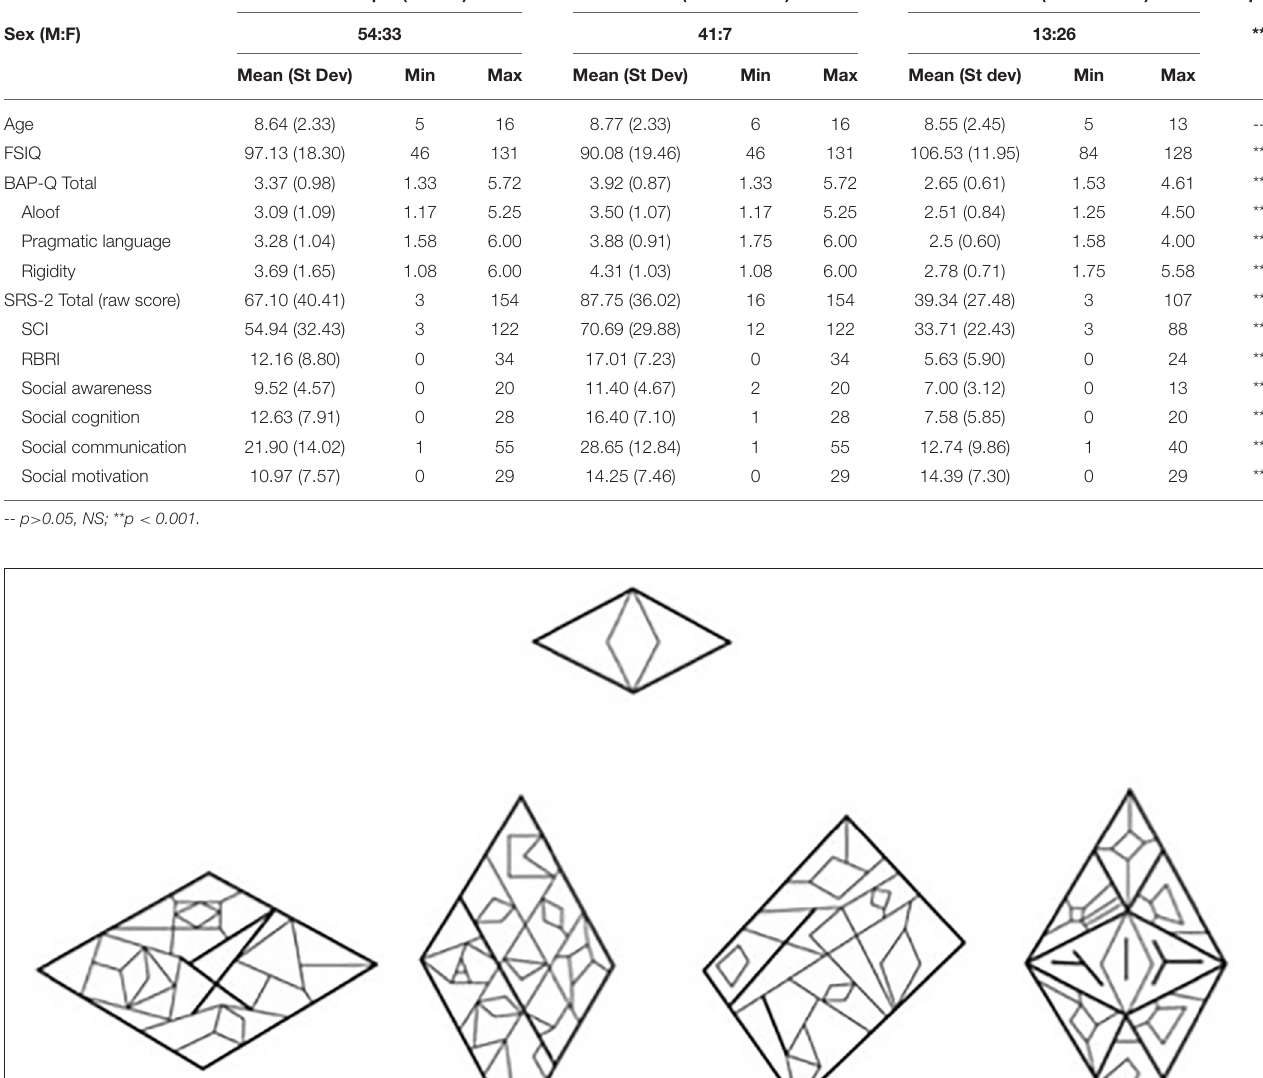
TABLE 1 | Sample demographics, BAP-Q, and SRS scores for entire sample and ASD and non-ASD subsamples. Total sample ( N = 87) ASD ( n = 48 of 87)